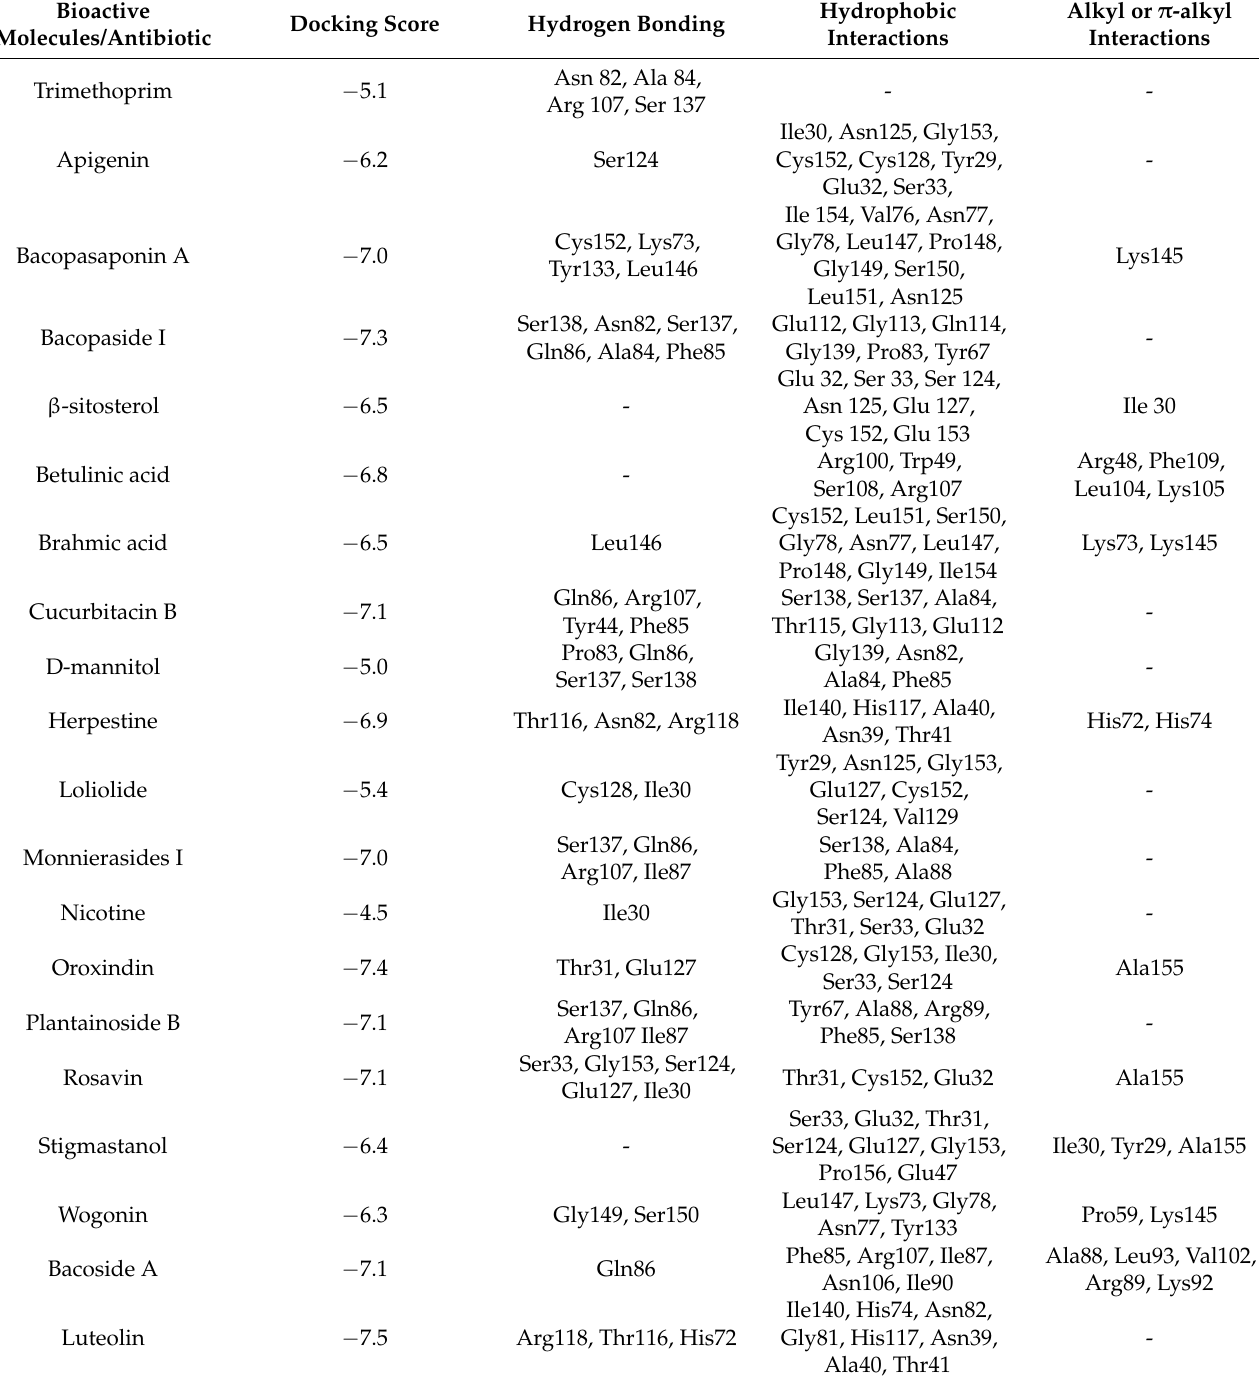
Table 4. Molecular docking analysis of major bioactive molecules from B. monnieri with